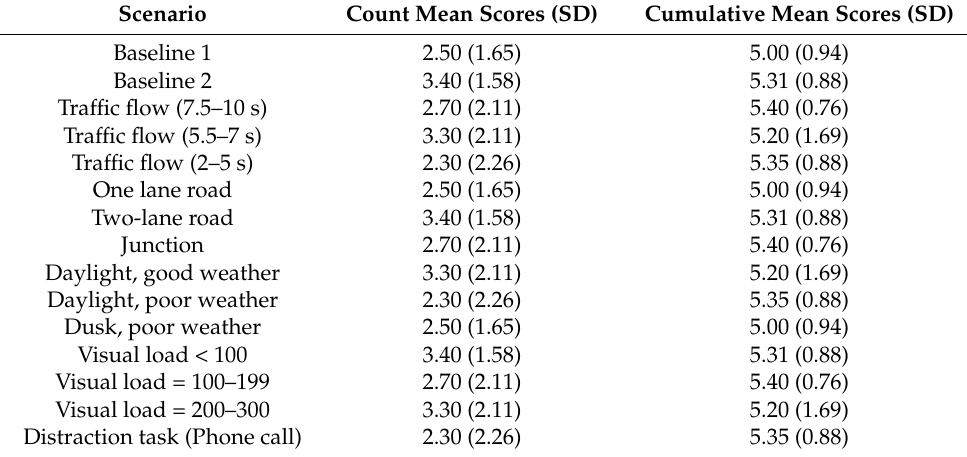
Table 4. SUS count and mean scores.